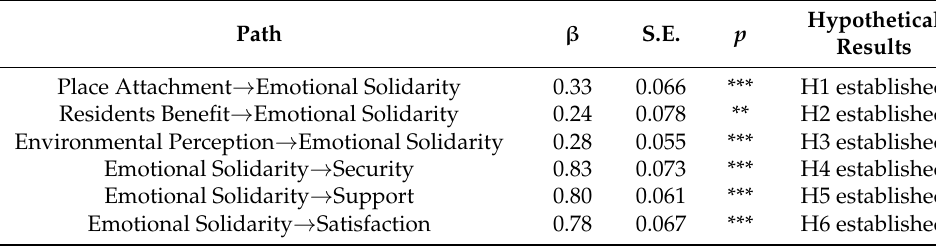
Figure 3. Model of residents’ perceptions and attitudes towards tourism. Table 4. Model fitting path coefficient.